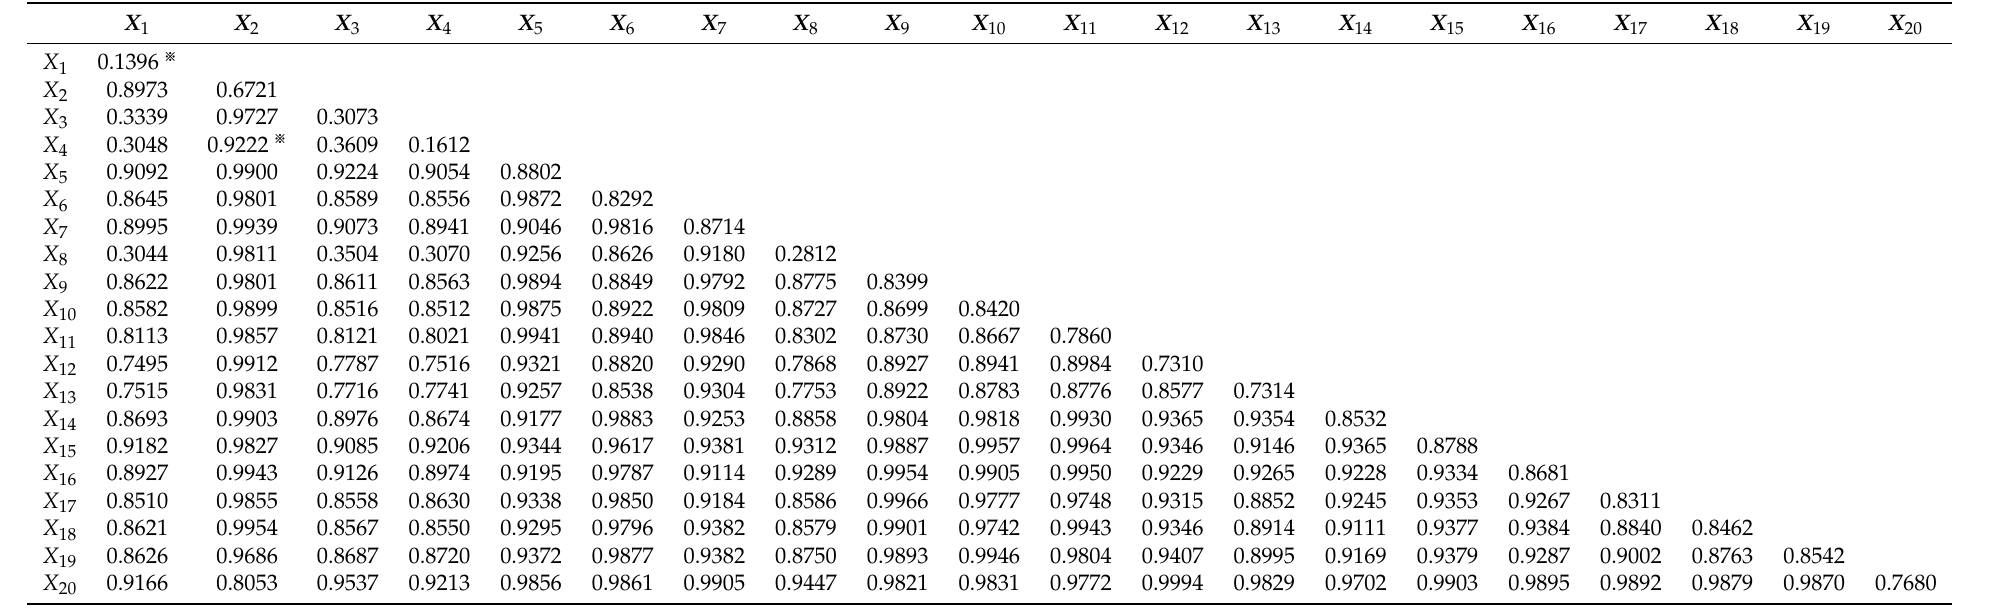
Table A1. Analysis of interaction effects of urban service-land area in